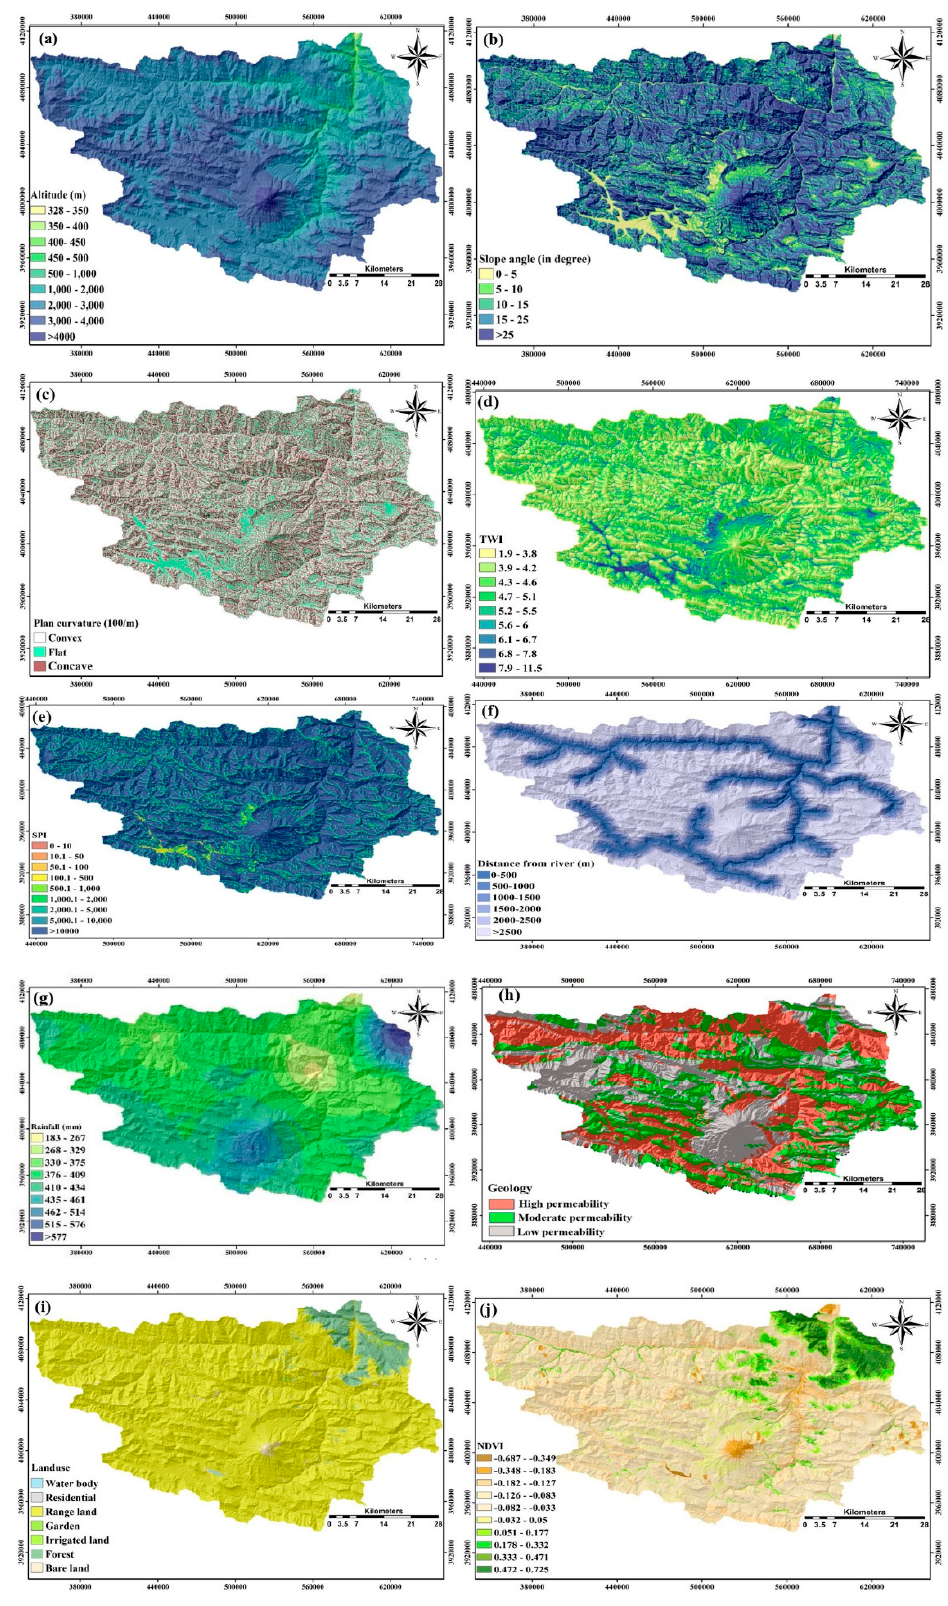
Figure 3. Flood-conditioning factors of the study area: ( a ) Altitude (m), ( b ) Slope angle (In degrees), ( c ) plan curvature (100 / m), ( d ) topographic wetness index (TWI), ( e ) Stream power index (SPI), ( f ) distance from river (m), ( g ) rainfall (mm), ( h ) geology, ( i ) land use, and ( j ) NDVI.